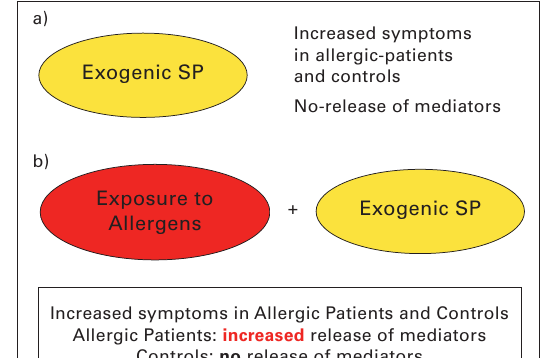
(SP) results in nasal symptoms without liberating mediators in both allergic and healthy people (a). After nasal allergen exposure allergic subjects show an ele- vated concentration of mediators in the nasal lavage fluid, while the lavage of healthy persons does not show such a re- sponse (b, [23,